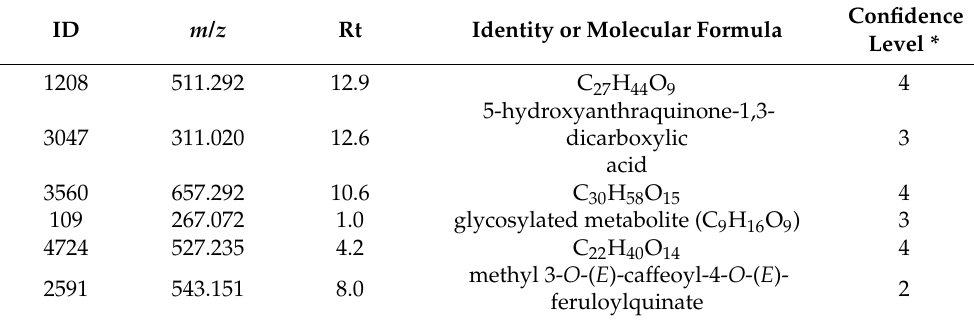
Table 2. Discriminant metabolites of the p á ramo massif of origin of 113 taxa of Espeletiinae selected as nodes in the decision tree (Figure 3). Refer to Figure 3 for geographic localities and concentration thresh- old associated with each metabolite ID. See Supplementary Information for compounds annotation.